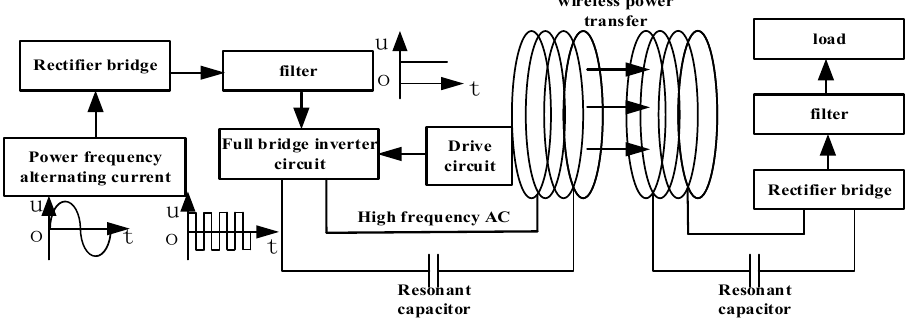
Figure 1. Basic schematic of radio charging.